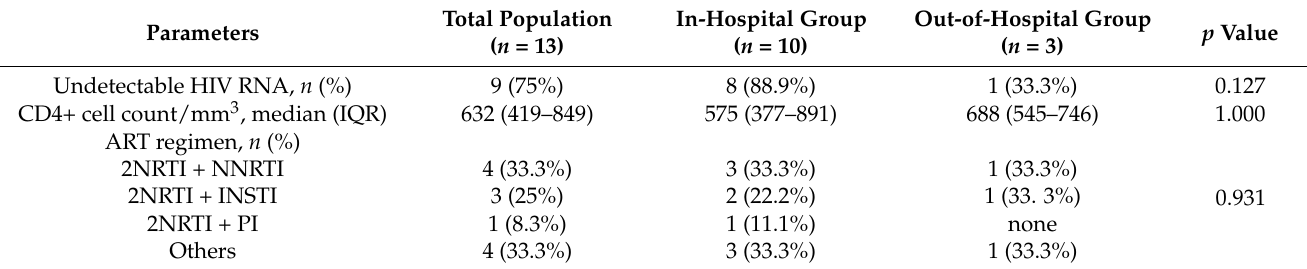
Figure 1. Flow chart of study enrollment. Table 2. Patients with HIV/HCV